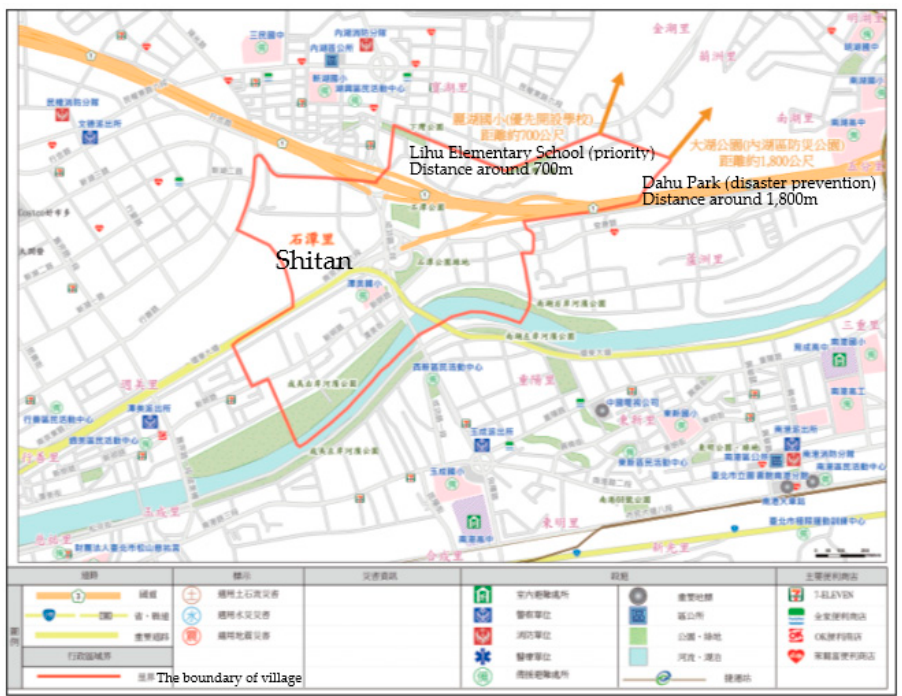
Figure 1. A village’s evacuation map in Nei-Hu District. Source: village evacuation map by the Taipei City Government.